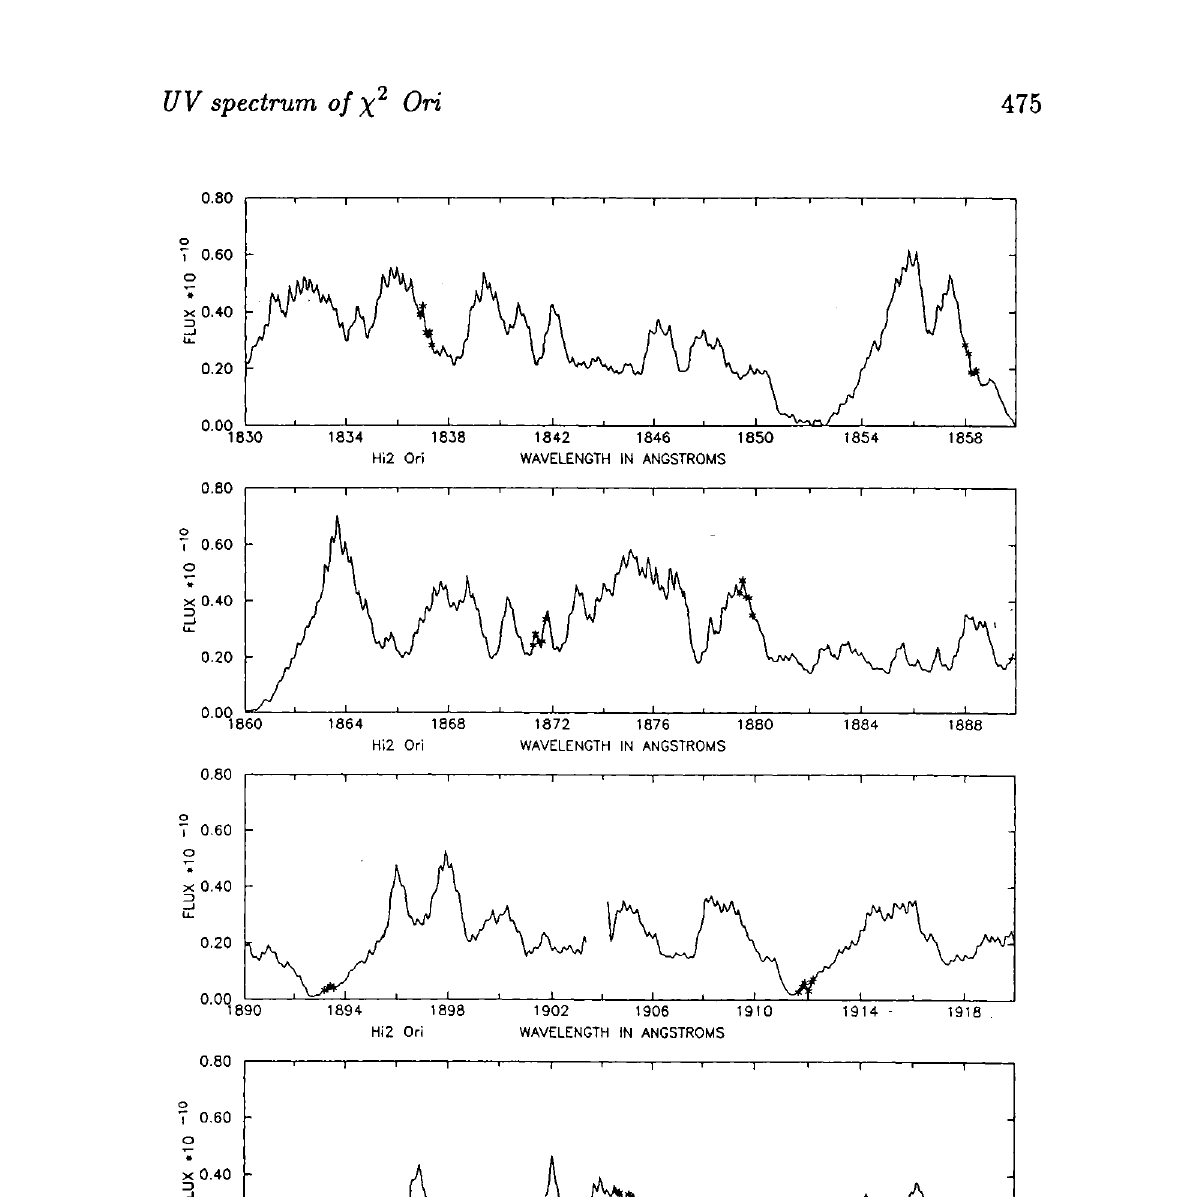
Fig. 9. SWP spectrum of x 2 Ori for spectral region 1830-1950